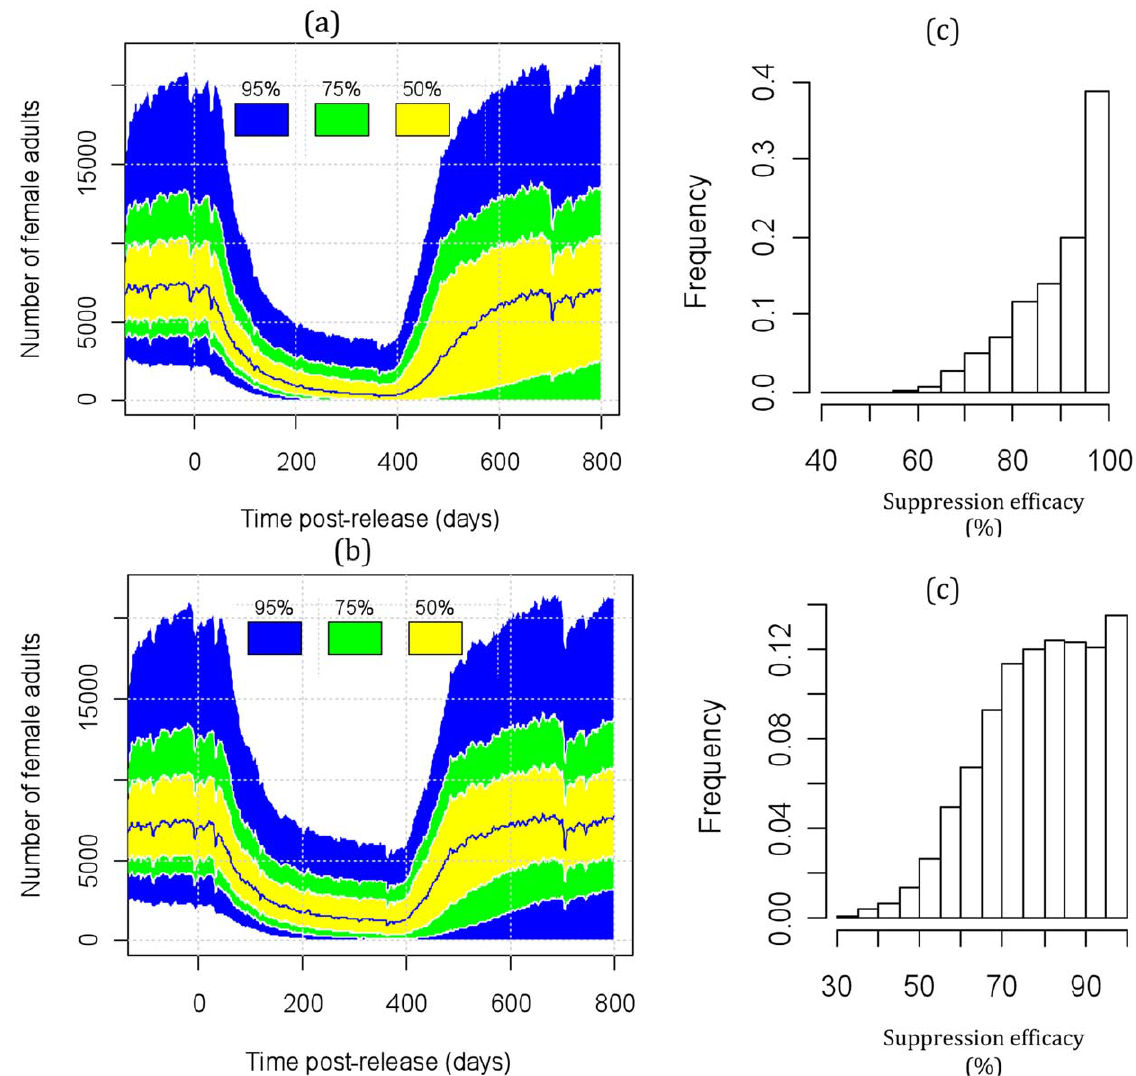
Figure 5. Uncertainty in the predicted population density across the entire simulated area with weekly releases of FK male adults for one year. Adults carrying one FK construct are released into the resident population (with natural heterogeneity). a) homogeneous male adult releases; b) point source uniform male adult releases. The yellow, green and blue shadings represent the 50%, 75% and 95% confidence intervals of the prediction, respectively. Grey represents the output boundary of all runs. The release starts at day 0 with burn in time of 200 days for the population to reach equilibrium. The suppression efficacy is measured by the percentage reduction in female adult population density, based on the reference density averaged over 3 weeks before the release and the suppressed density averaged over days 200–400 after the release. Histograms of mosquito population suppression efficacy in the 5000 model runs for release scenarios (a) and (b) are shown in panels (c) and (d).